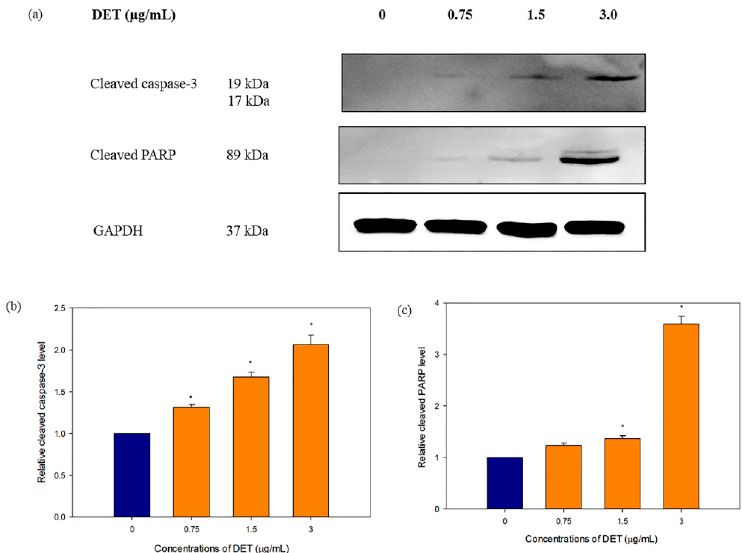
Figure 5. Effect of deoxyelephantopin on the apoptosis-related protein expressions in HCT116 cells. HCT 116 cells were treated with different concentrations of DET (0.75, 1.5 and 3.0 µg/mL) for 24 h. ( a ) Representative image of cleaved caspase-3 and cleaved PARP expression level with their respective western blot band intensity; ( b ) The bar chart showed the relative protein expression of cleaved caspase-3 level; ( c ) The bar chart showed the relative protein expression of cleaved PARP. The data expressed as mean ± S.E. from three individual experiments. Asterisks indicate significantly different value from control (* p < 0.001).